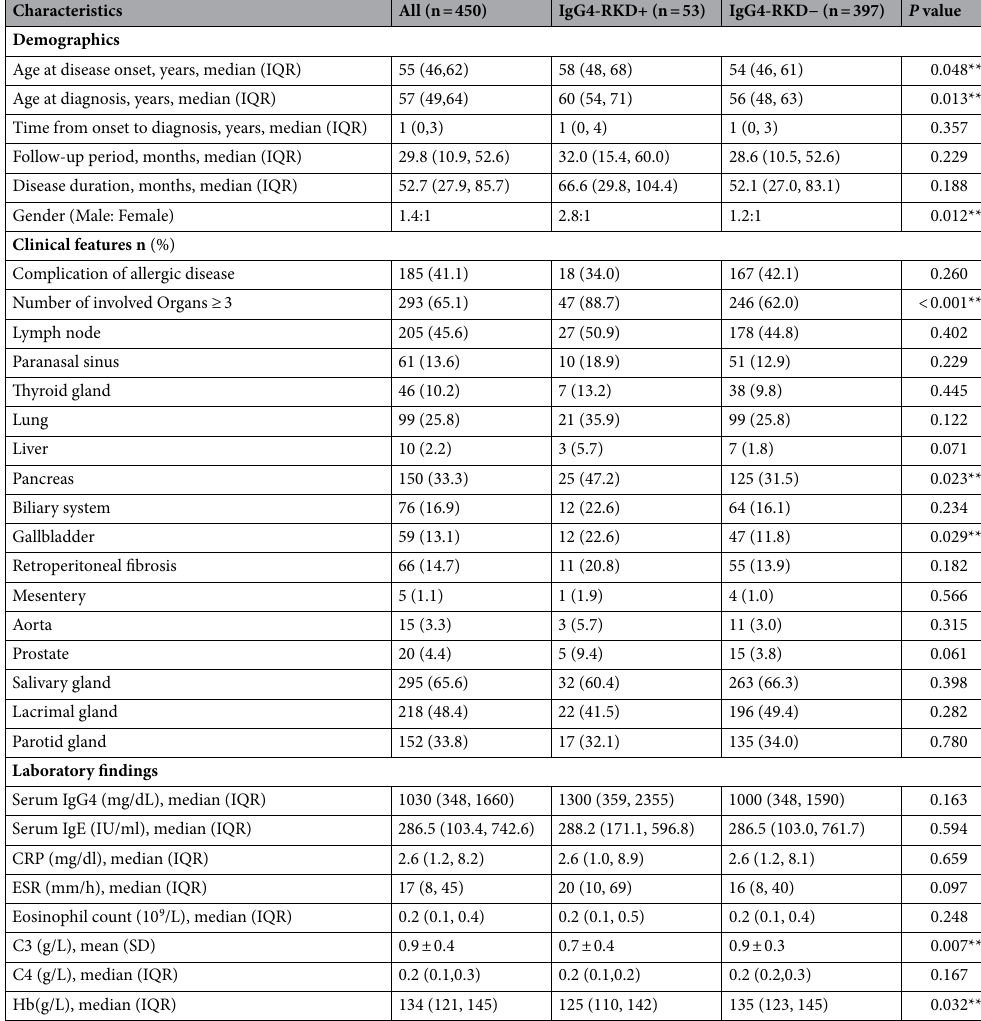
Table 1. Demographic, clinical features and laboratory findings of 450 IgG4-RD patients. IgG4-RKD + vs IgG4-RKD − ** P <